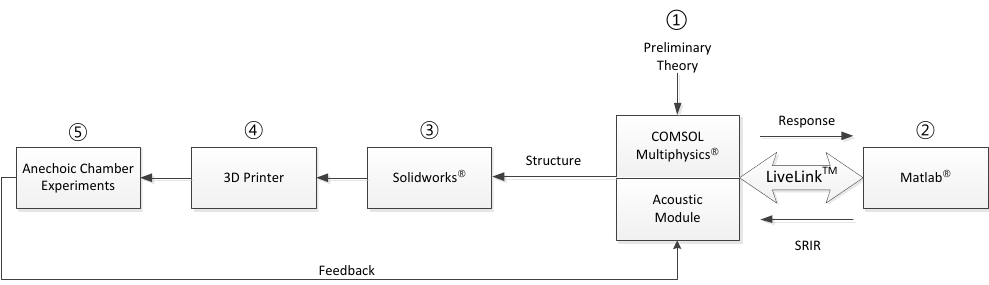
Figure 4. Workflow of the RML system development [41].